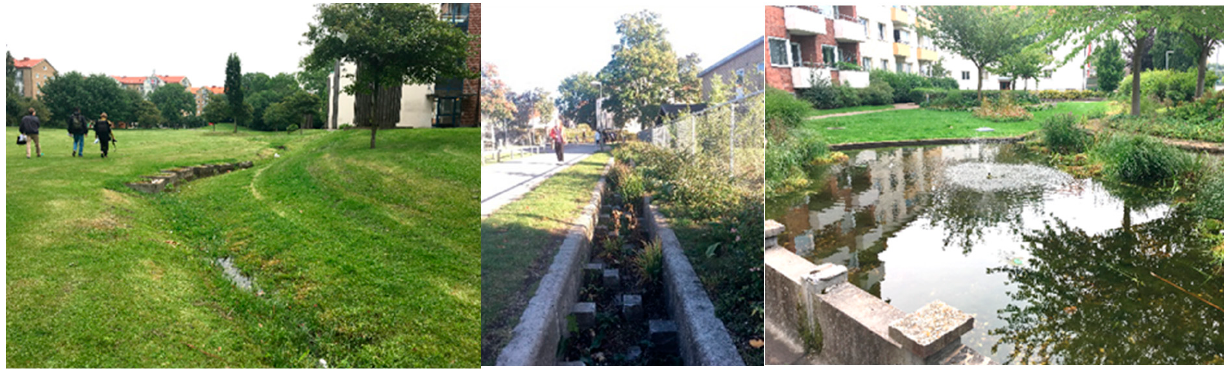
Figure 2. From left to right: Sunken lawn (Augustenborg remodelled park); sample of paved canal; sample of wet pond. Photographs by Misagh Mottaghi.